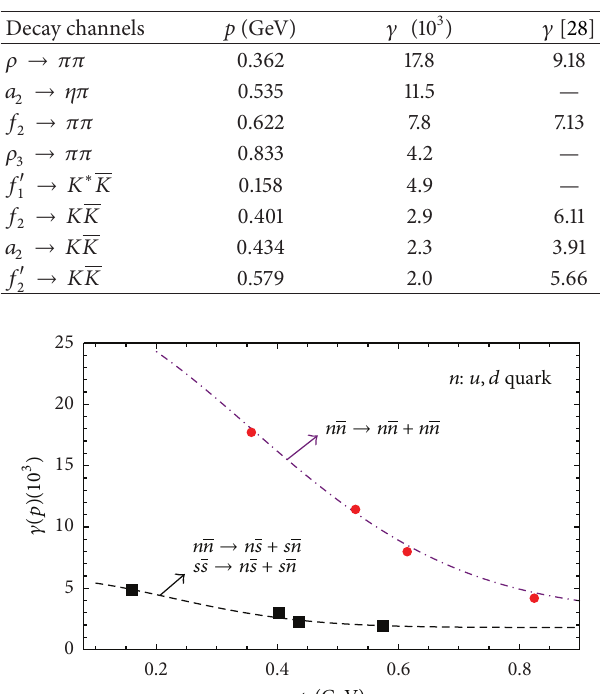
Table 6: Values of 𝛾 in different channels and comparison with the results given in [28]. Here, 𝜌(770) , 𝑎 2 (1320) , 𝑓 󸀠 1 (1420) , 𝑓 2 (1270) , (1525) and 𝜌 (1690) have been studied. 𝑓 󸀠 3 2